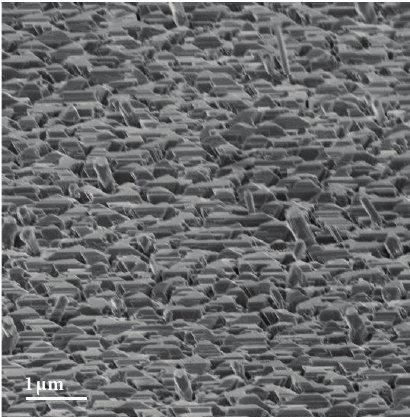
Figure 3: Bright-field TEM image of a [110]-oriented NW. The simulation of the corresponding faceted structure is superimposed. In the inset, the di ff raction pattern of the NW corresponding to the [1–10] Zone Axis (ZA) is